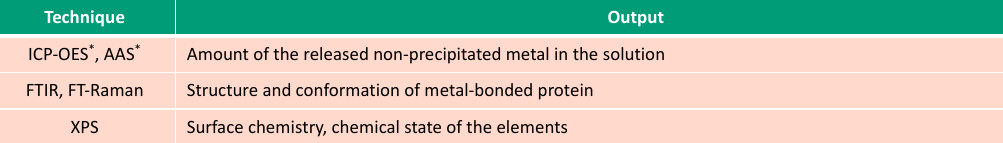
Figure 4. Spectroscopic techniques used for investigation of albumin-metal binding (* in-situ techniques).